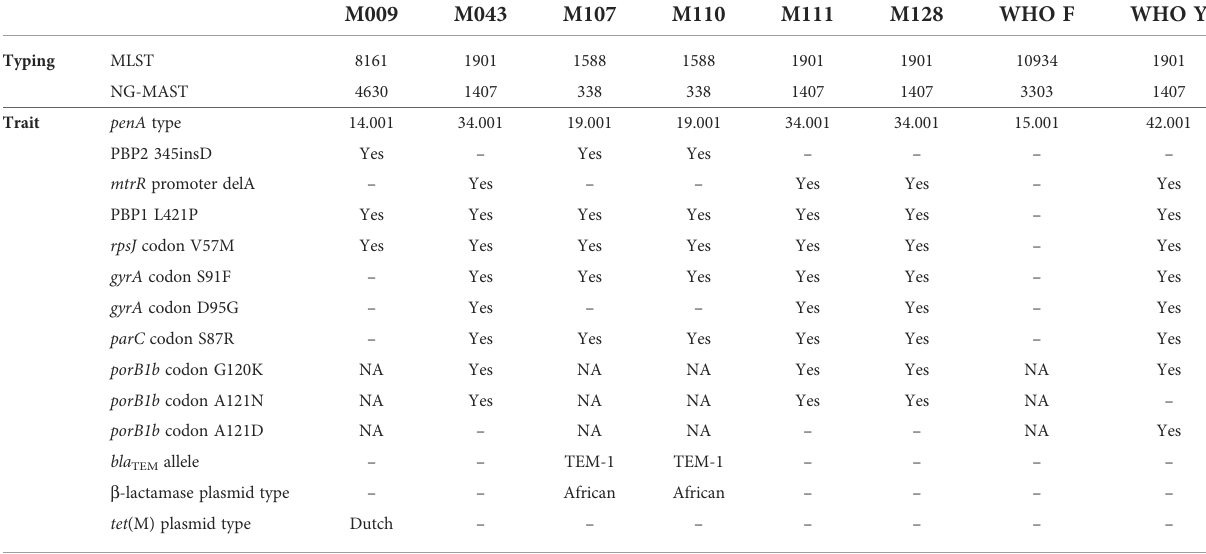
TABLE 2 Genetic traits of relevance for antimicrobial resistance in Neisseria gonorrhoeae isolates included in this